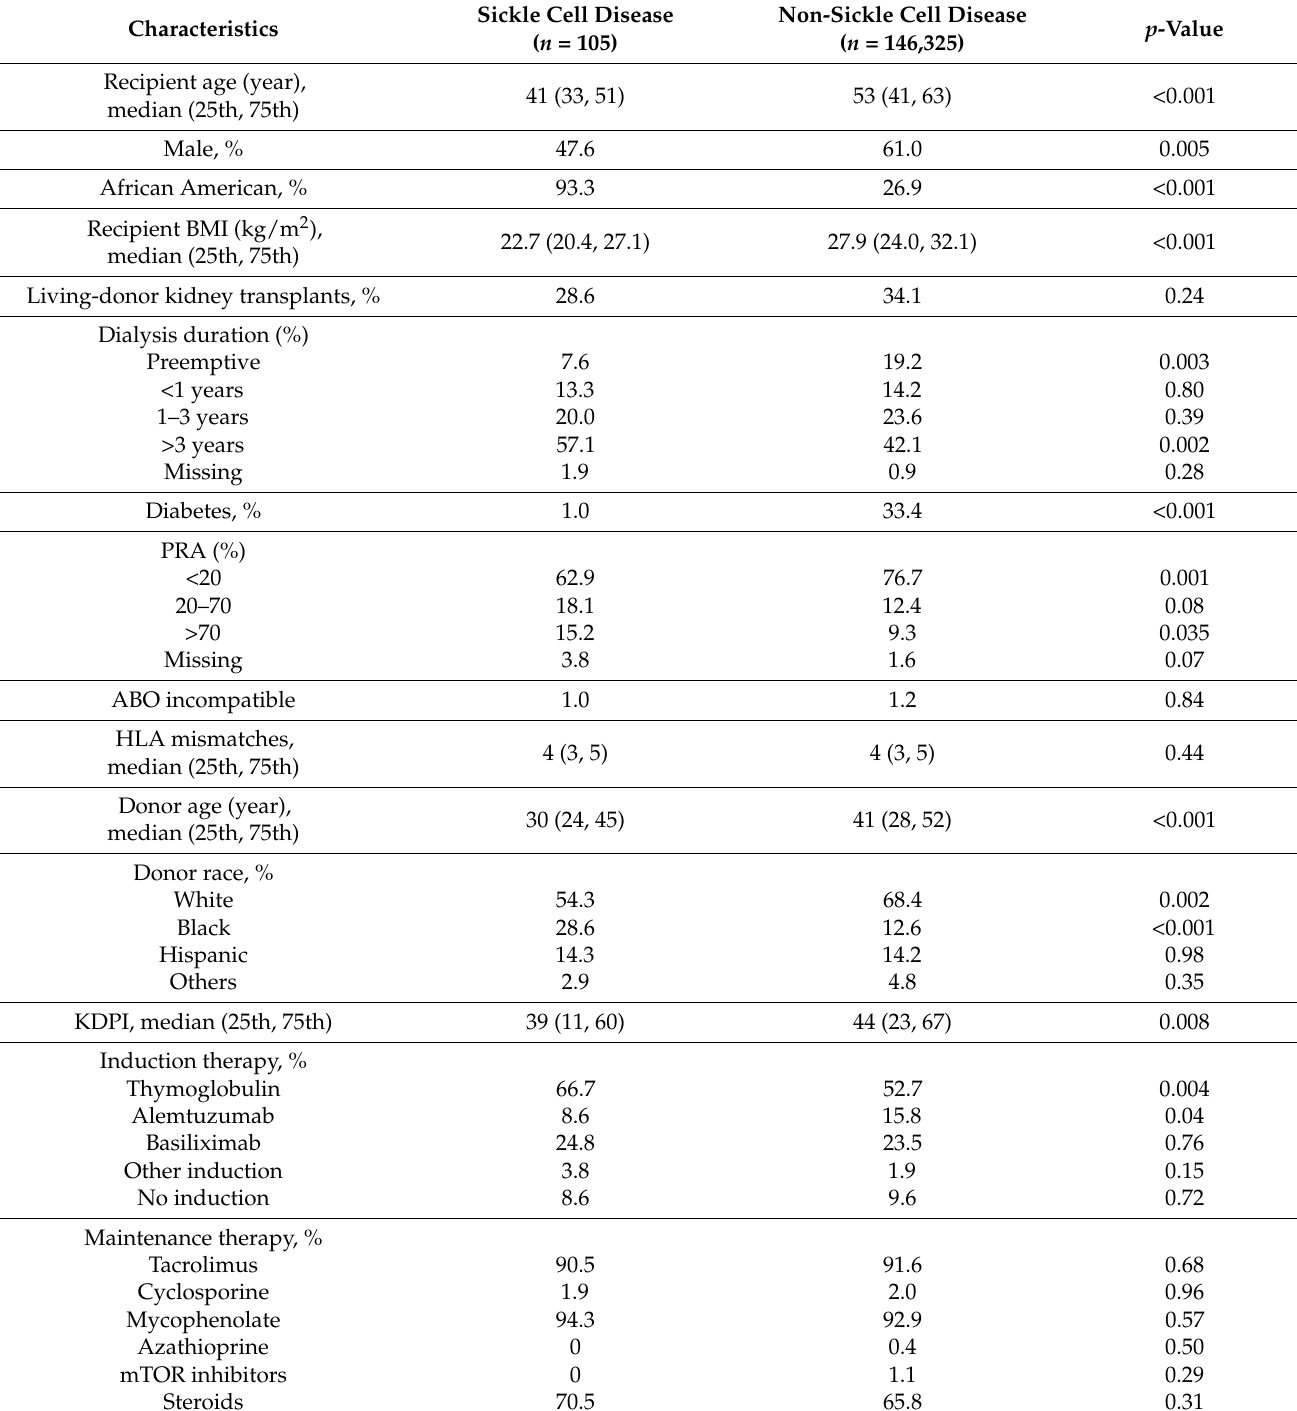
Table 1. Clinical characteristics between sickle cell disease and non-sickle cell disease kidney transplant recipients.